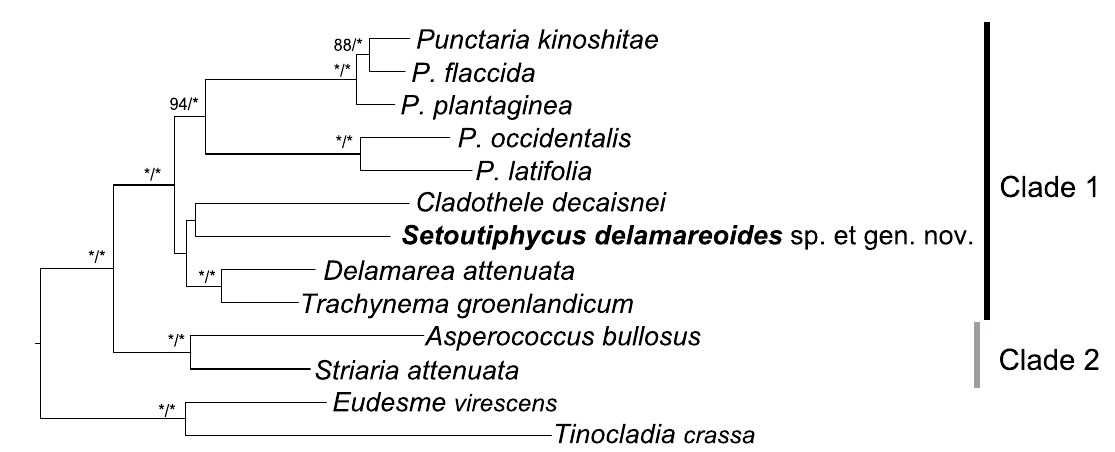
Figure 4. Maximum Likelihood molecular phylogeny of selected ectocarpalean species including Setoutiphycus delamareoides gen. & sp. nov. based on concatenated sequences of ( cox 1, cox 3, atp B , psa A , psb A , rbc L genes) (7696 bp). Numbers on branches indicate bootstrap values (%) from ML analysis (left) and posterior probabilities from Bayesian analysis (right). Asterisks (*) indicate 100% bootstrap (ML) and 1.00 posterior probability (Bayesian) values. Only bootstrap values > 70% and posterior probabilities > 0.90 are shown. [Artwork by T. Hanyuda and H. Kawai].